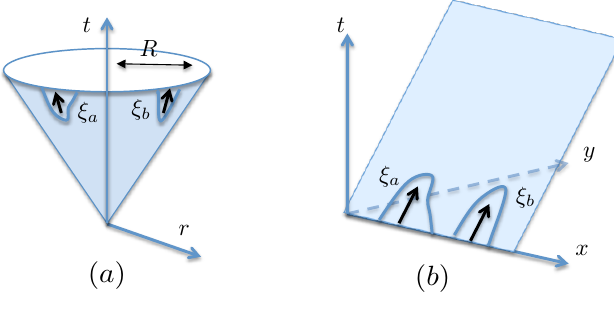
Figure 1 . (a) Dilatataions that deform the boundary of ball at t = R , and act locally at particular angular variables (cid:10) a and (cid:10) b (b) Translations in the null direction that act locally in x